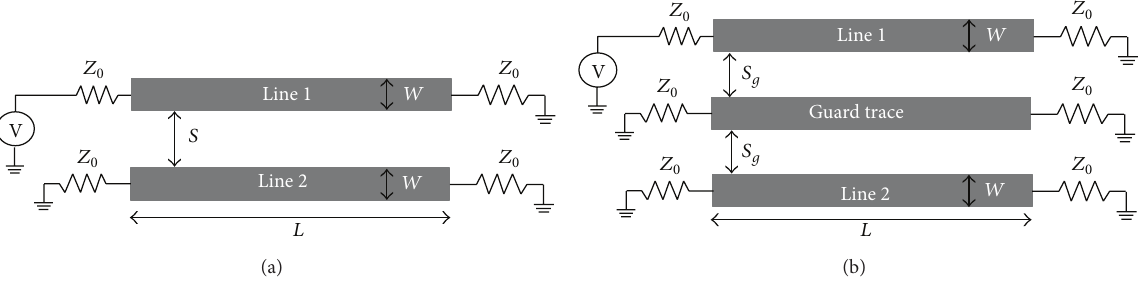
Figure 2: (a) Parallel microstriplines and (b) microstriplines with a guard trace.